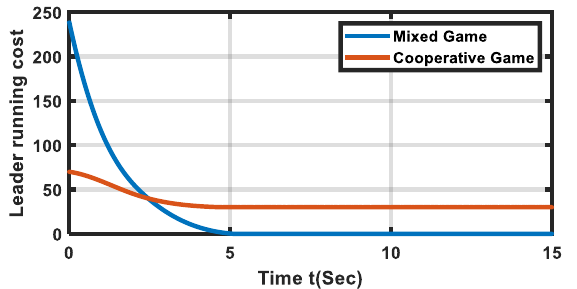
Figure 9. Leader running cost for developed mixed game theory-based distributed approach and the traditional cooperative game-based centralized approach.